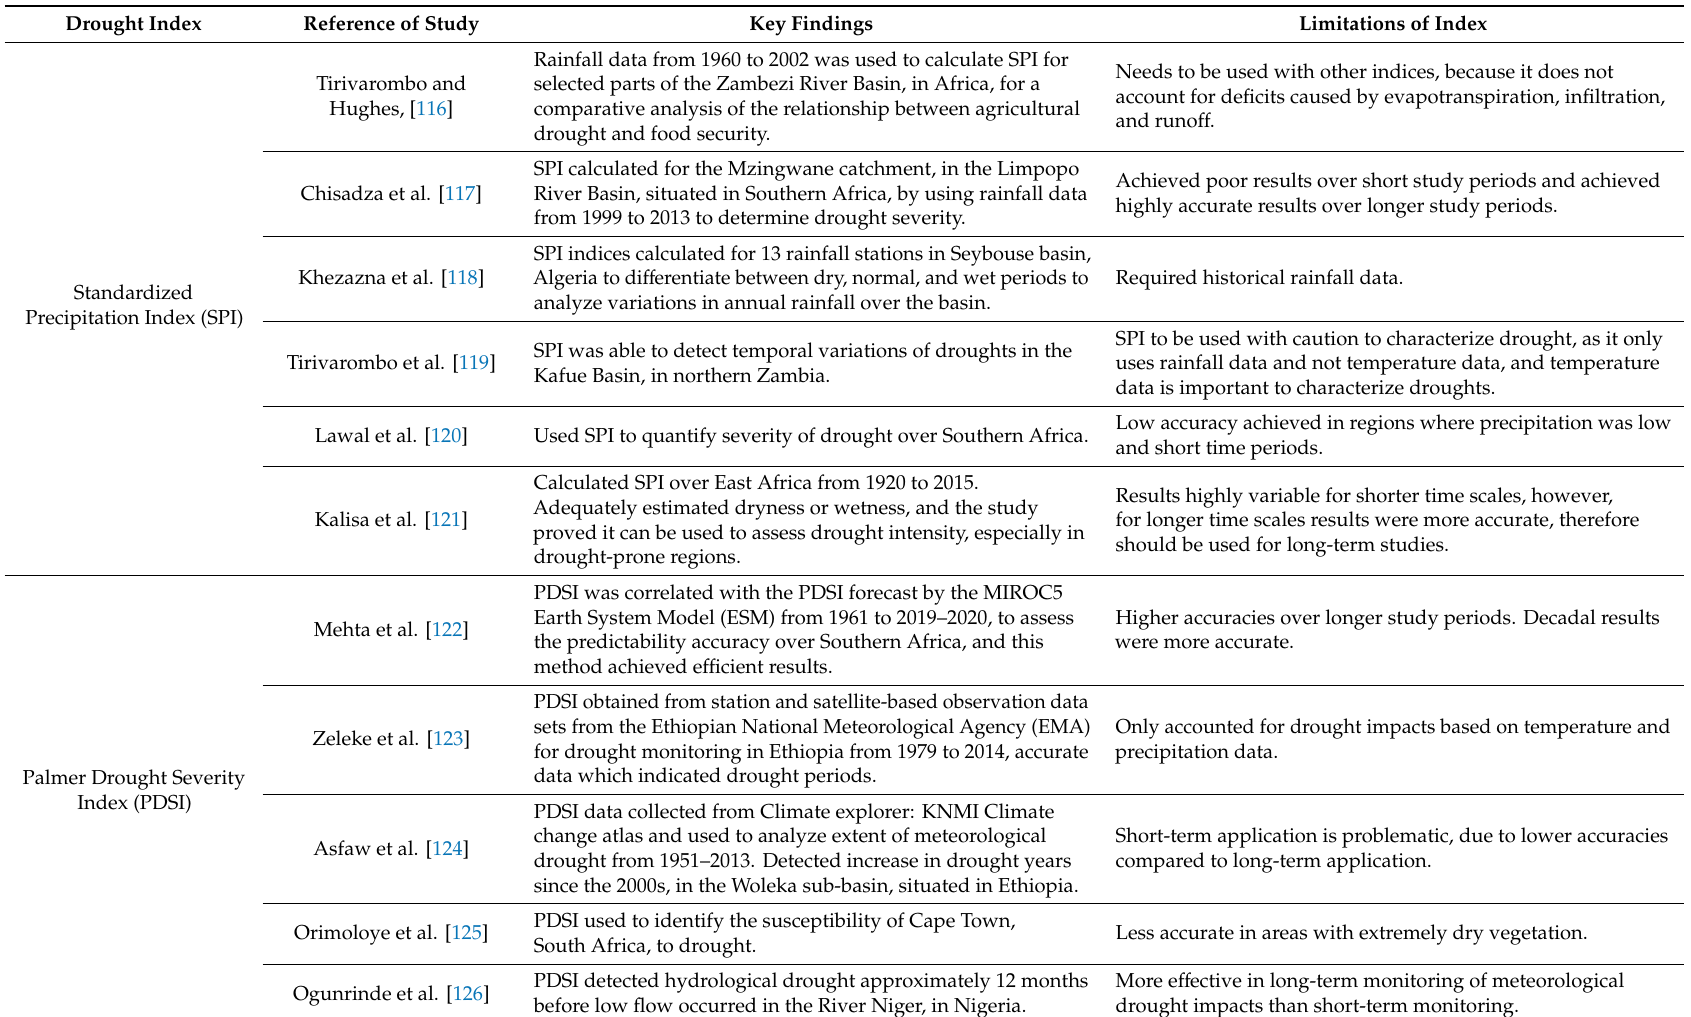
Table 3. Drought indices used and their performance in previous